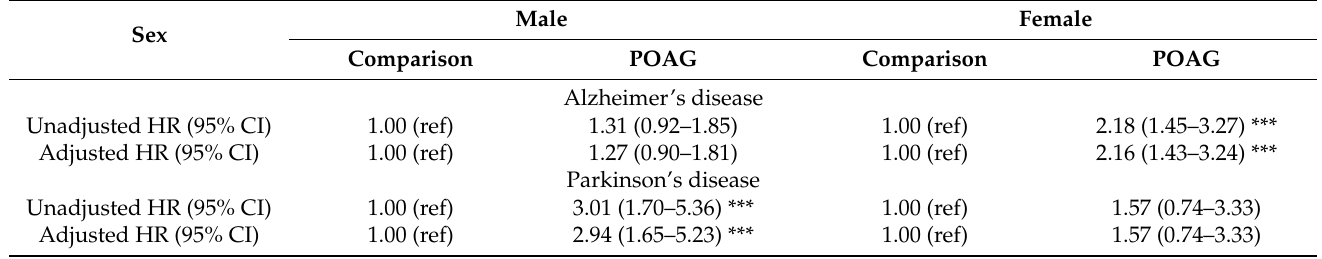
Table 5. Risk of Alzheimer’s disease and Parkinson’s disease in POAG patients according to the